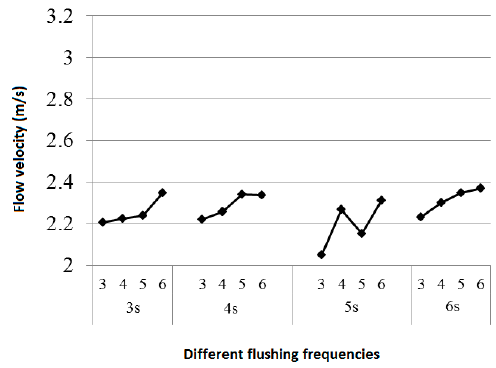
Figure 17. Flow velocity comparison of all the frequencies (rectangular nozzle on top of the pipe).